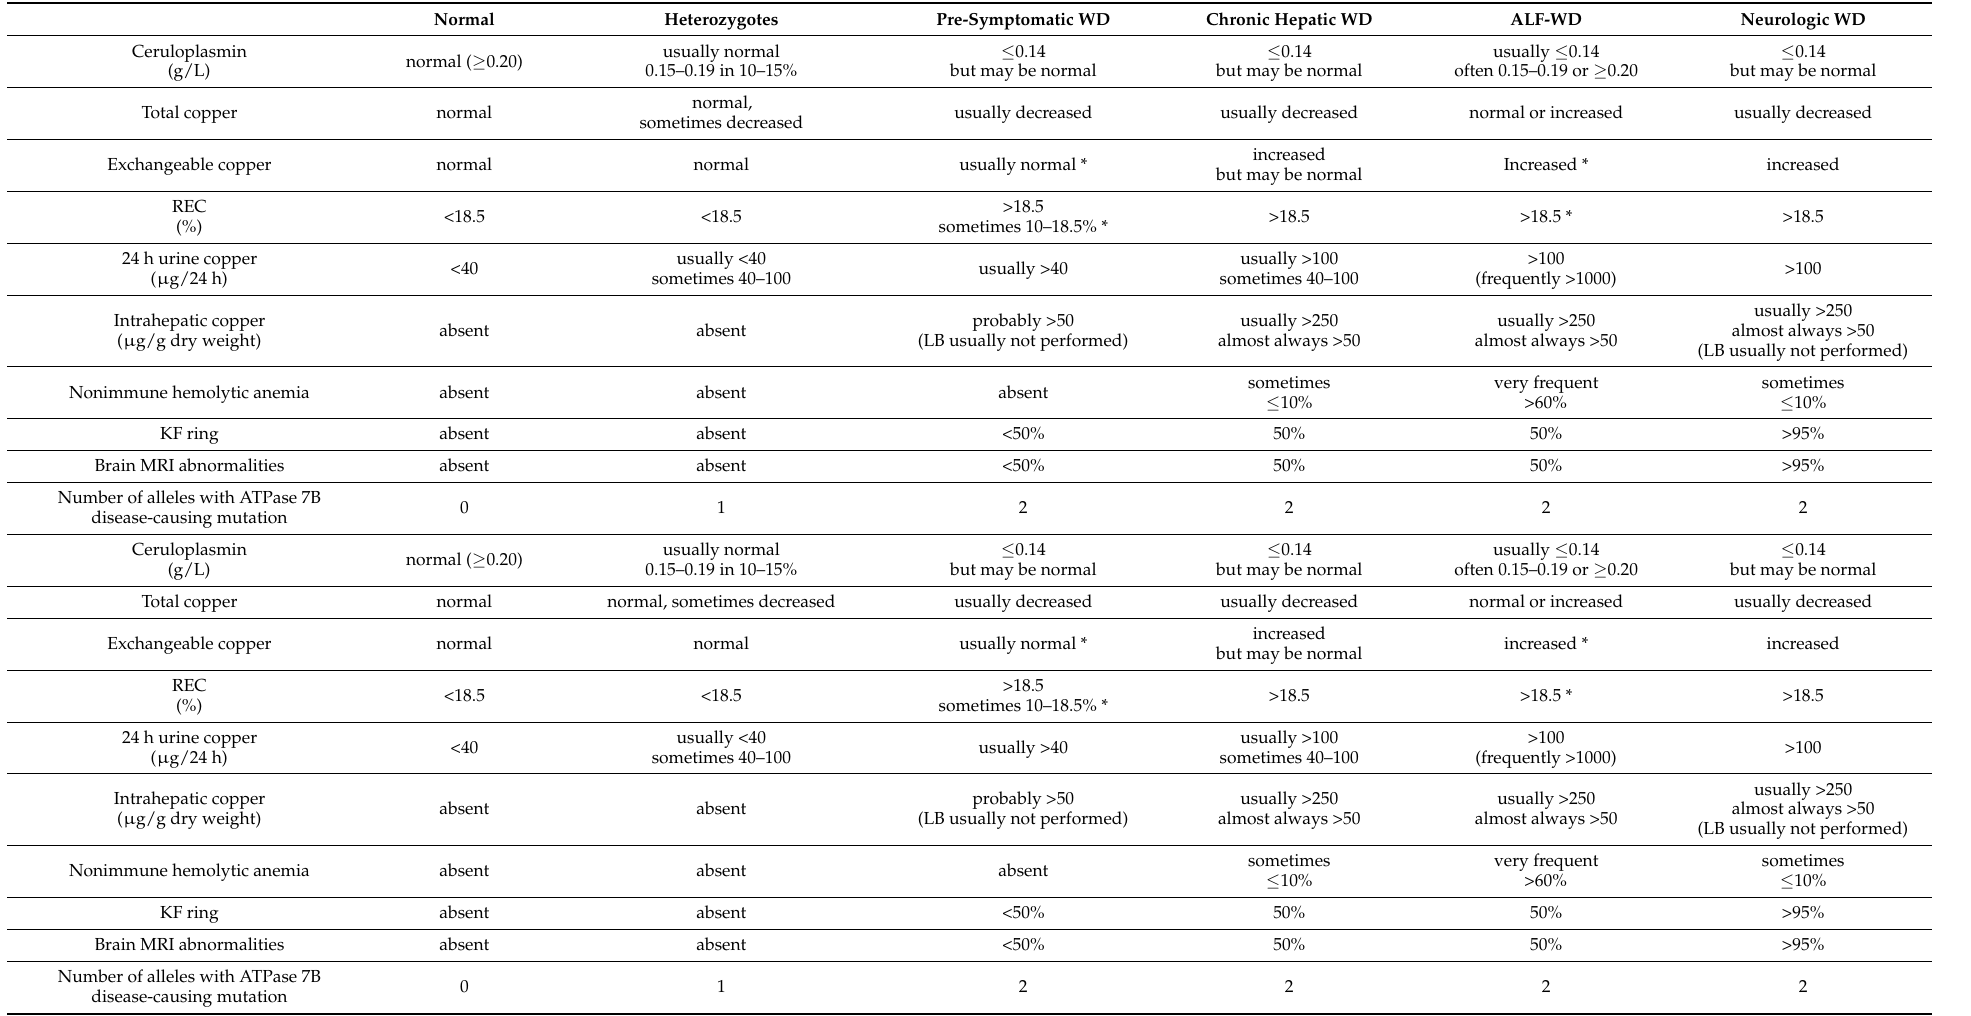
Table 2. Classical features of diagnostic tests for